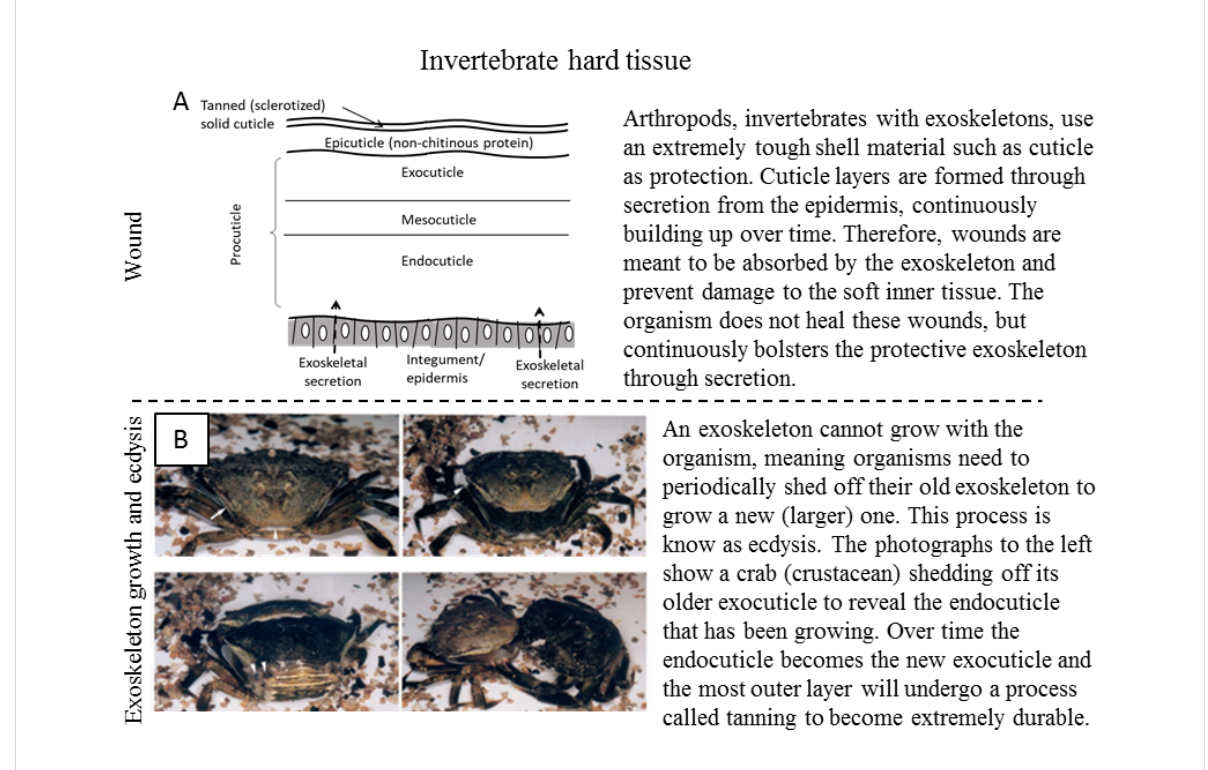
Figure 5: Healing response in the hard tissue (exoskeleton) of invertebrates to (A) wounds and (B) shedding. (A) The exoskeleton of invertebrates consists of several layers being secreted from the epidermis on the inner side. (B) The exoskeletons of arthropods cannot grow with an organism and are periodically cast off in a process known as ecdysis to reveal new exoskeleton growth. Reproduced with permission from [69], copyright 2000 The Company of